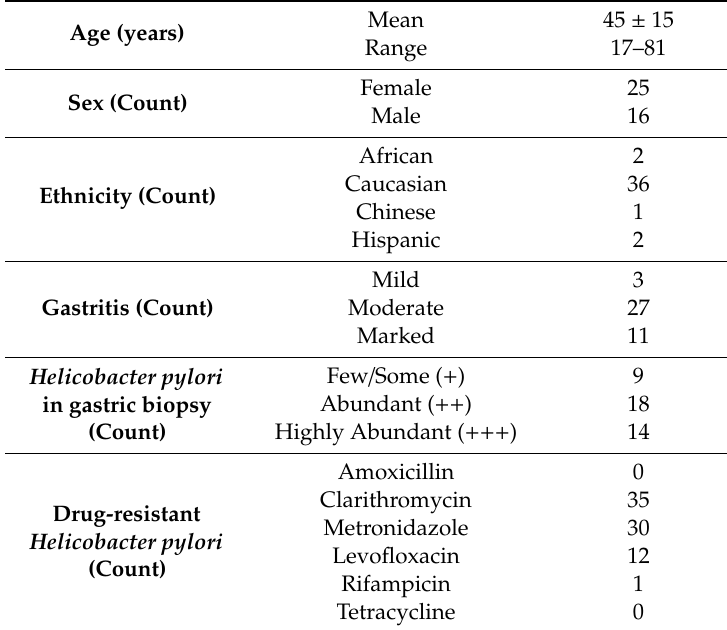
Table 1. Display of the epidemiological data of the patient population and drug resistance in H. pylori